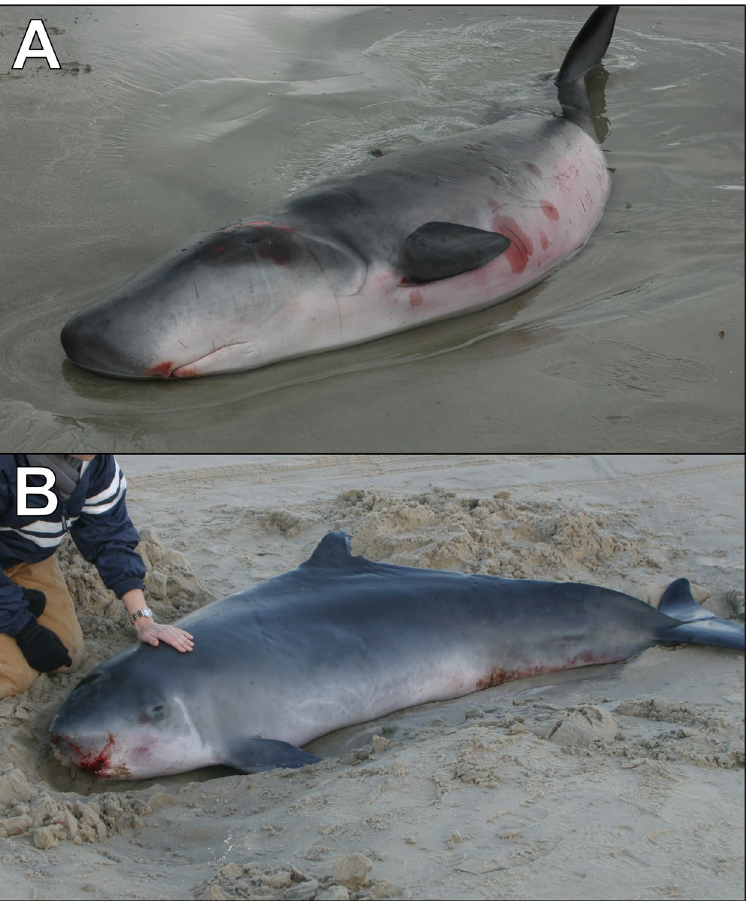
Figure 4. Stranded individuals of Kogia breviceps ( A ) and K . sima ( B ). Photo credits: UNCW Marine Mammal Stranding Program ( A ) and the Virginia Aquarium ( B